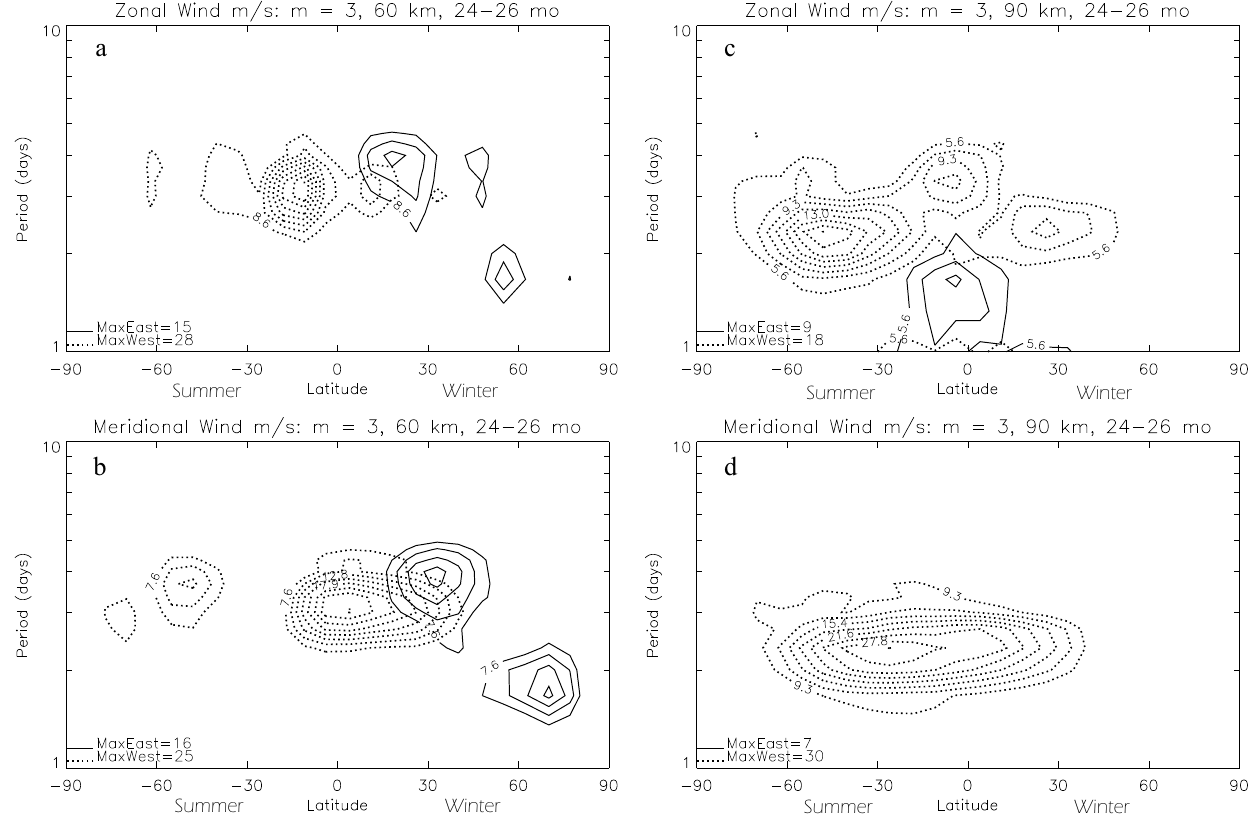
Fig. 10. Spectra of m=3 PWs propagating eastward (solid lines) and westward (dashed), for the zonal ( a ) and meridional ( b ) winds at 60km derived from a short time span of 2 months following solstice with the Sun in the Southern Hemisphere. In the Fourier analysis, running windows are applied that are a factor 3 larger than the derive periods. To suppress chaff, the lowest 30% of the contour maxima are suppressed, but the maximum amplitudes are stated in each panel. Note the eastward propagating waves in the winter hemisphere, where the zonal jets (m=0) are directed eastward (Fig. 1b), and the westward propagating waves in the summer hemisphere, where the zonal jets are westward (Fig. 1b). At mid latitudes, these are presumably Rossby type PWs, which slowly propagate westward relative to the zonal winds they are embedded in. As seen from the ground, their apparent oscillation periods or propagation velocities are greatly affected (Doppler shifted) by the mean zonal winds. Westward propagating Rossby-gravity waves are apparent in the meridional wind maxima near the equator and in the zonal wind maxima that tend to straddle the equator. Analogous to (a) and (b), the zonal ( c ) and meridional winds ( d ) are presented at 90km. This shows that the largest PWs occur in the summer hemisphere, which is consistent with the trend seen in Fig. 8. The eastward propagating zonal winds around the equator (Fig. 10c) represent Kelvin